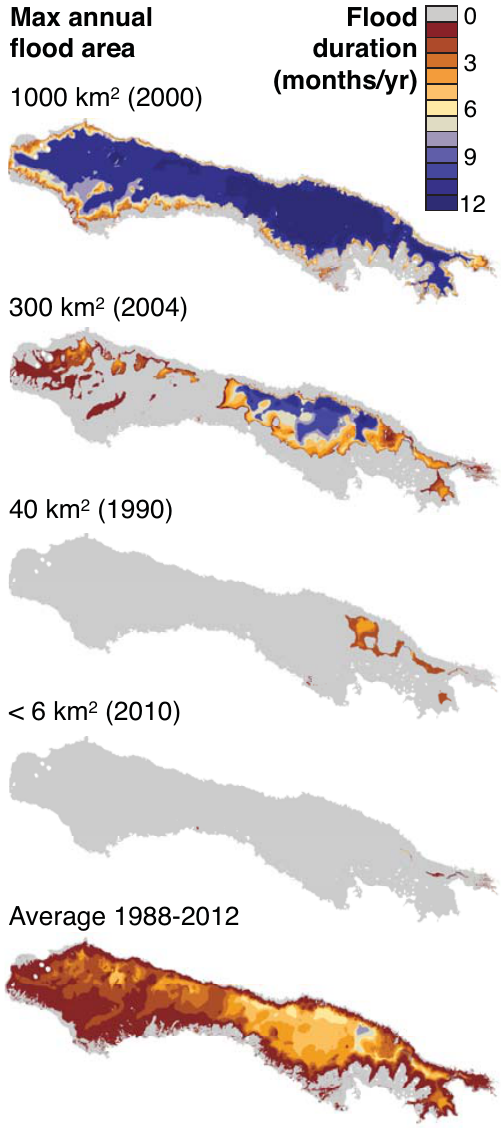
Figure 6. Maps of the Fortescue Marsh floodplain including flood duration isohyets over the rain year (November–October) repre- senting examples of the main connectivity thresholds: wettest year ∼ 1000km 2 ) ; a very large flood year in observed in 2000 ( F A max ∼ 300km 2 ); the long-term mean flood year in 1990 2004 ( F A max 2 ) and the ∼ 40km 2 ) and a dry year in 2010 ( F ( F A A max < 6km max 1988–2012 average.